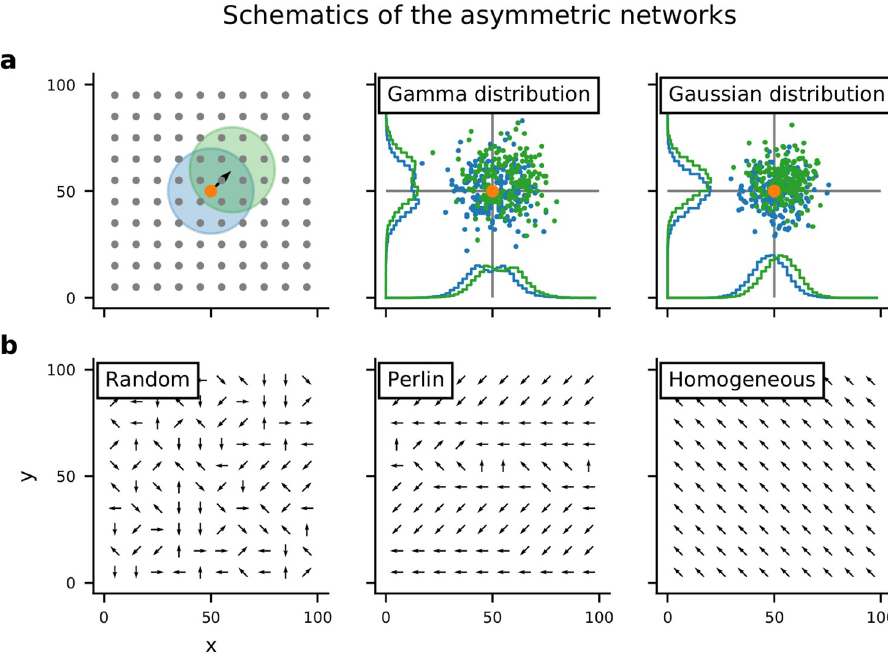
Fig 1. Schematics of the asymmetric network models. (a:left) Neurons were arranged on a regular 2-D grid, folded to form a torus. The colored circles indicate the symmetric (blue) and asymmetric (green) spatial connectivity schemes. The pre-synaptic neuron is marked by the orange dot. (a:center) Locations of post-synaptic neurons chosen according to the asymmetric (green) or symmetric (blue) connectivity. In this case the distance-dependent connectivity profile varied non-monotonically, according to a Γ distribution. This connectivity profile was used for purely inhibitory network models. (a:right) Same as in the center panel, but here the distance-dependent connectivity profile varied monotonically according to a Gaussian distribution. This connectivity profile was used in the present study for network models with both excitatory and inhibitory neurons. (b) Schematic of spatial distribution of connection asymmetries. Each arrow shows the direction in which the neuron makes preferentially most connections ( ϕ ). Here we show examples for random, Perlin and homogeneous configurations.